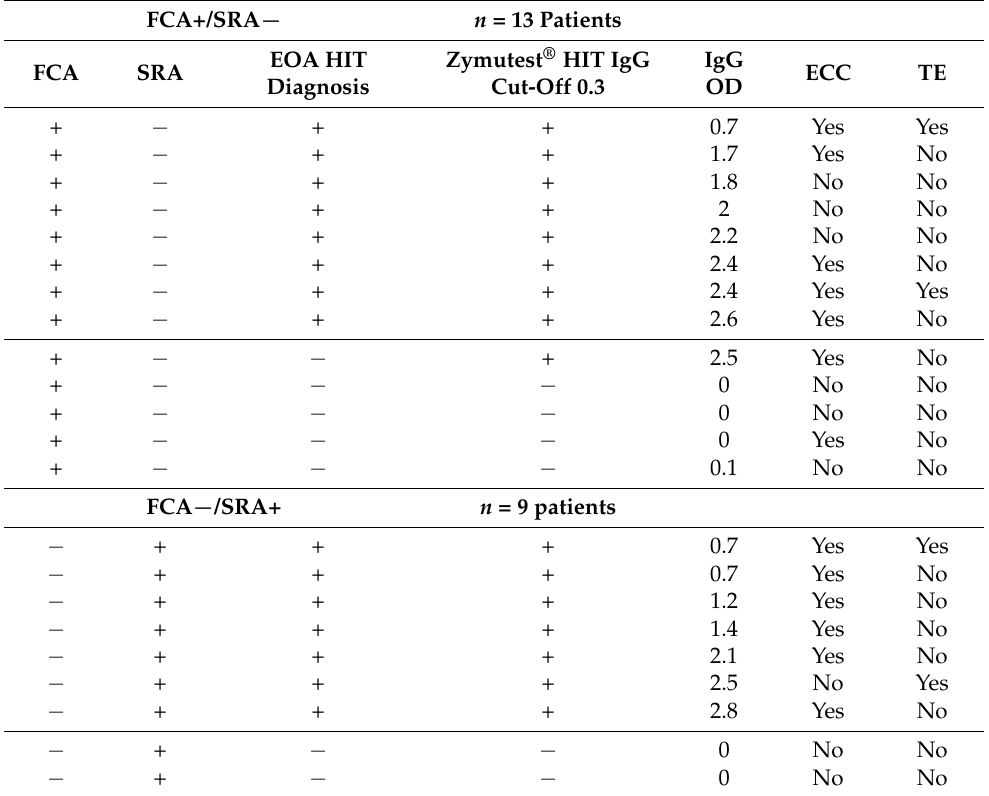
Table 5. Discordances between the FCA and SRA